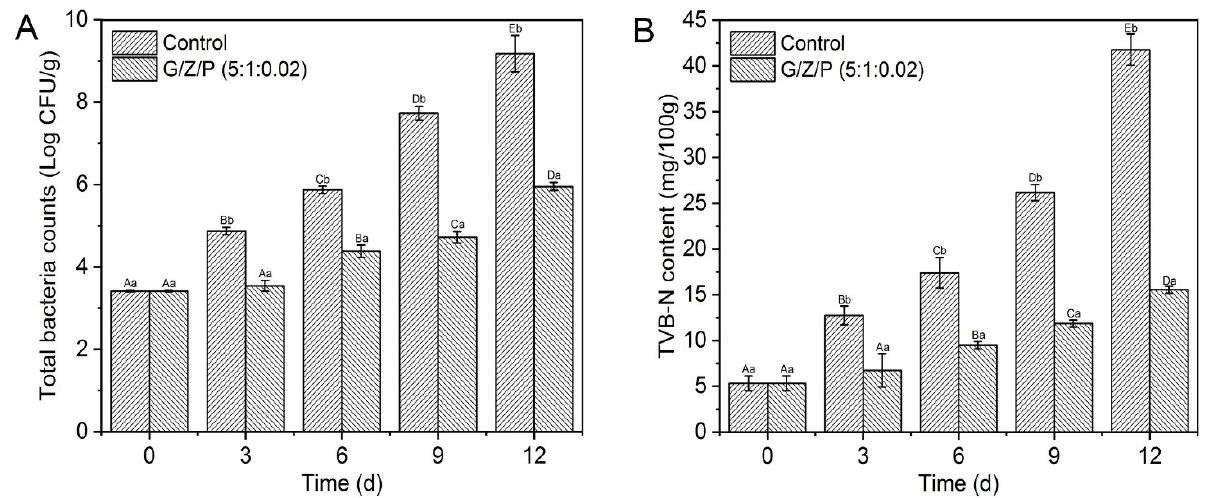
Figure 9. Impact of G/Z/P (5:1:0.02) nanofiber film on total viable counts ( A ) and TVB-N ( B ) of chicken breasts during storage. a,b Mean values in the bar, corresponding to the same days of storage, not followed by common lowercase letters, differ significantly ( p < 0.05). A,B,C,D,E Mean values in the bar, corresponding to the same group, not followed by common uppercase letter differ significantly ( p < 0.05).